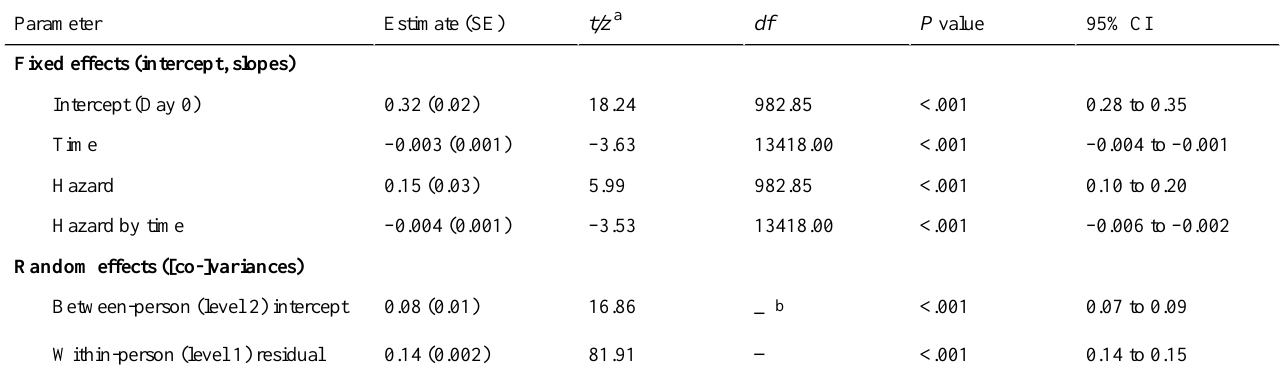
Table 4. Parameter estimates for linear growth model of daily (“yes”) responses per day as a function of hazard and nonhazard AUDIT group membership.